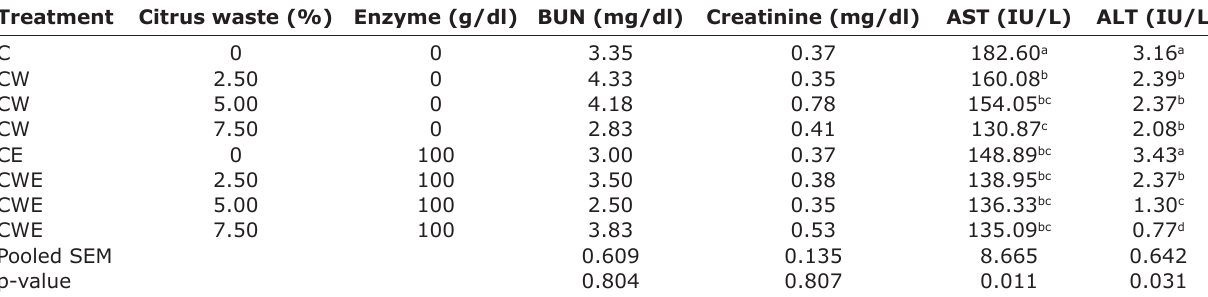
Table-11: Effect of citrus waste × enzyme on the liver and kidney function tests in broiler. Treatment